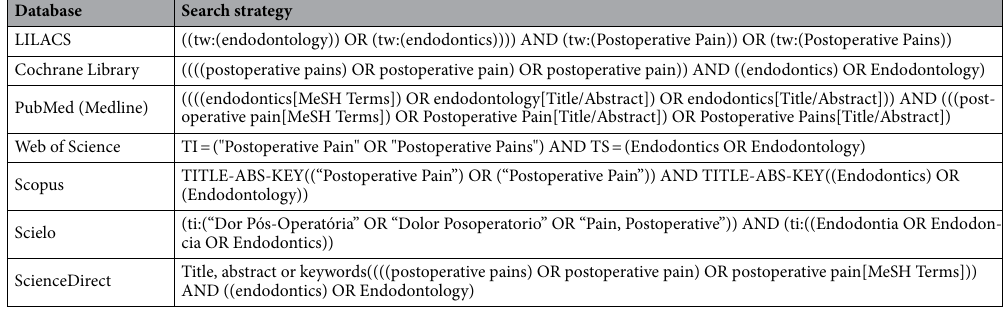
Table 1. Electronic databases used and search strategy. The electronic searches were performed until April 2021 with no restrictions of the start date. Studies published in English, Spanish, and Portuguese were included. MeSH medical subject